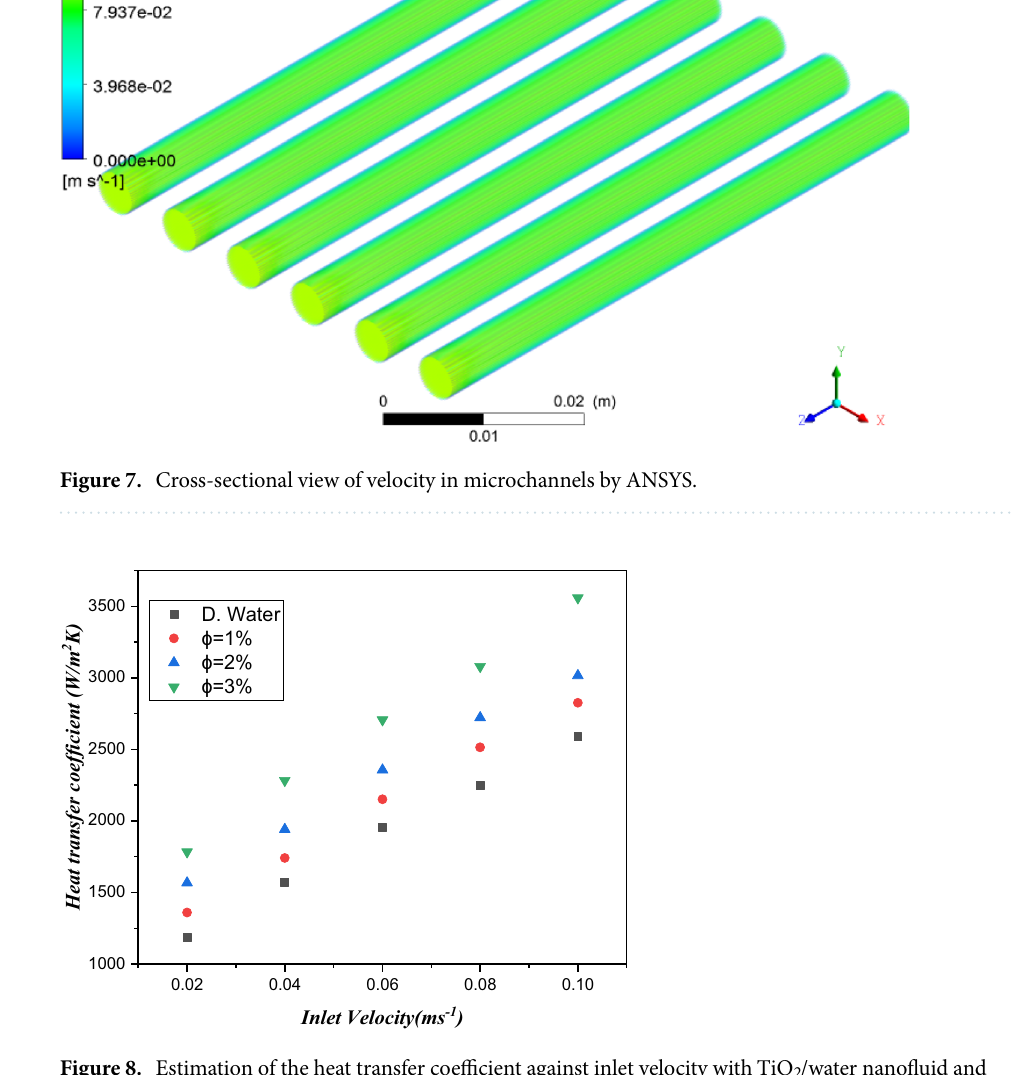
Figure 8. Estimation of the heat transfer coefficient against inlet velocity with TiO 2 /water nanofluid and distilled water in the circular